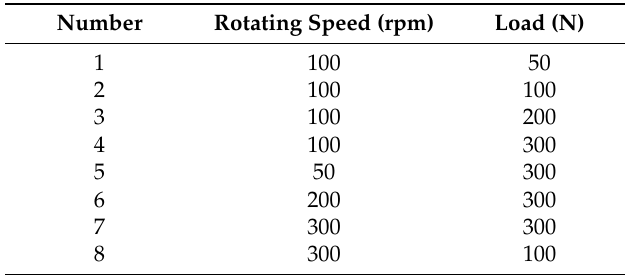
Figure 3. Schematic diagram of the friction and wear tester. Table 4. The frictional experiment arrangement of smooth and different texture densities under different loads and different speeds.